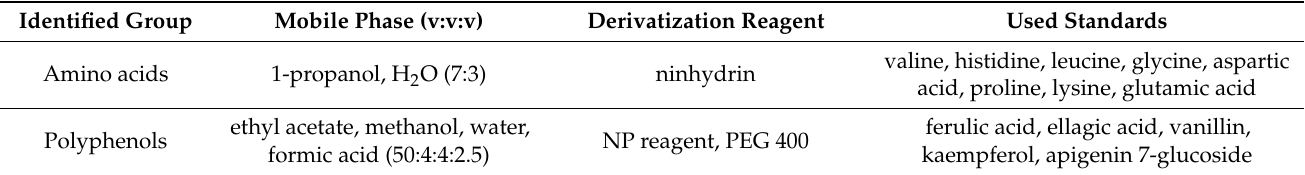
Table 2. Details of separations performed on HPTLC Silica gel 60 F 254